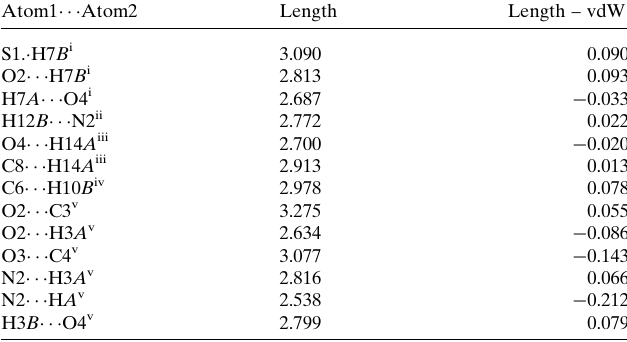
Table 2 Short contacts (A˚ ) in the crystal of compound 3 .